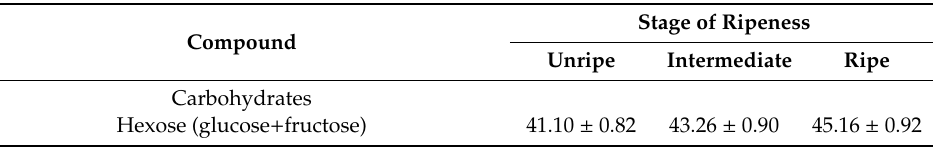
Table 2. Content of compounds in unripe, intermediate ripe, and fully ripe fruits of F. viridis , mg / g of fresh fruit weight ±